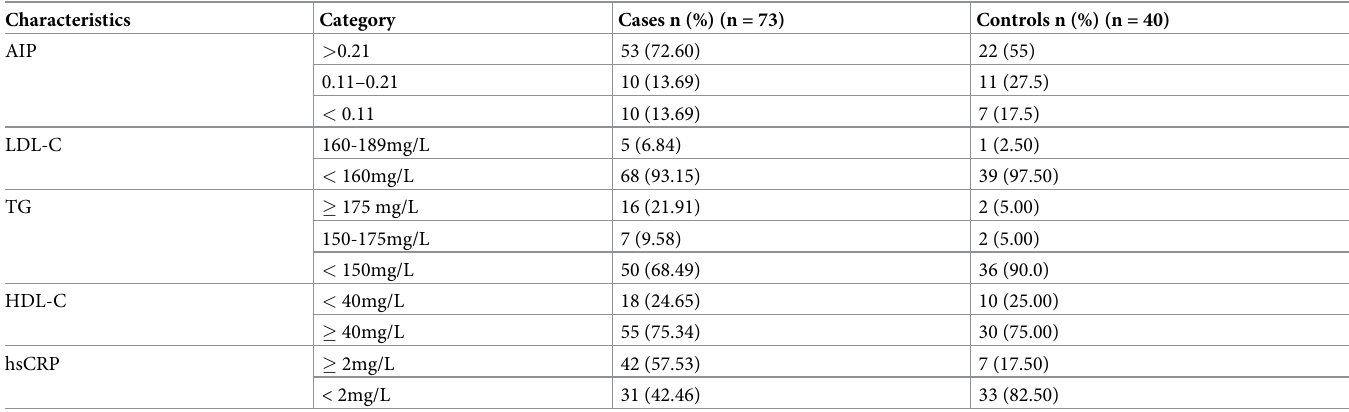
Table 2. Comparison of categorical value atherogenic lipid profile among study participants. Characteristics